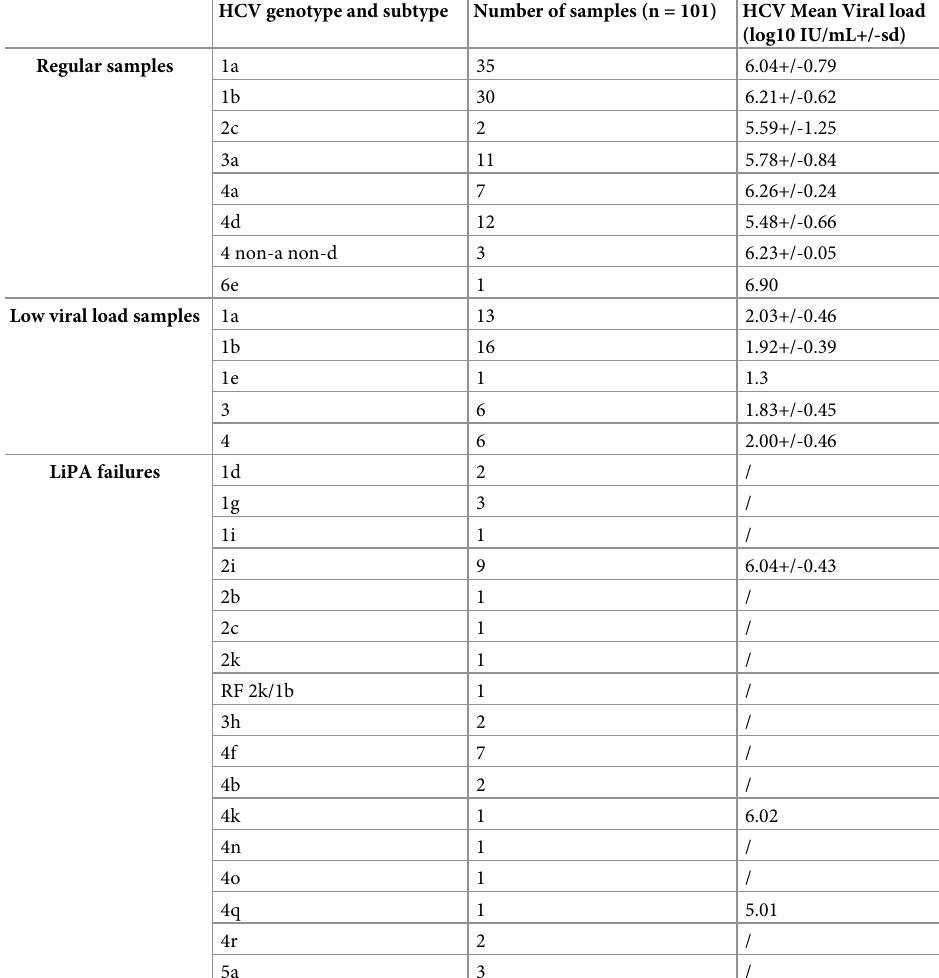
Table 1. Distribution of Hepatitis C virus (HCV) genotypes in studied samples (n =